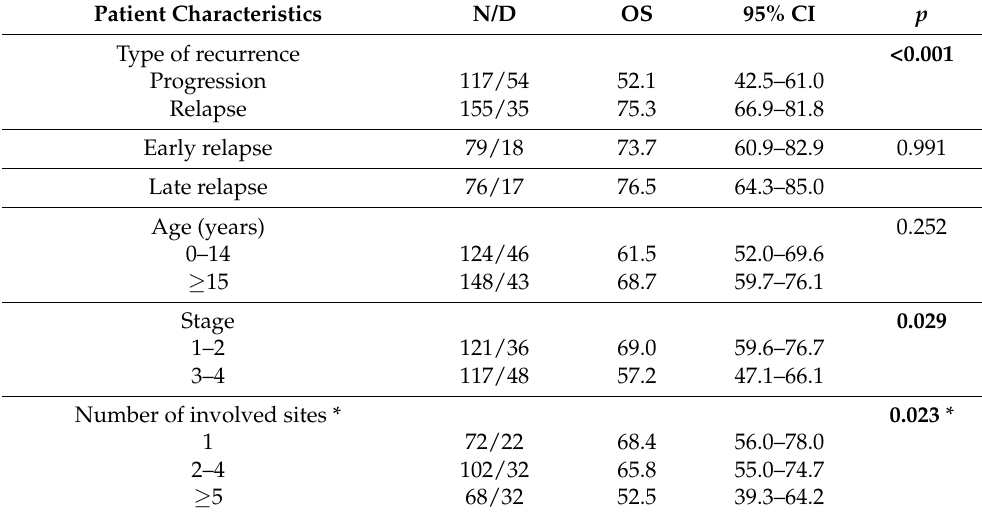
Table 6. Ten-year overall survival of 272 patients with classical Hodgkin’s lymphoma after recurrence by characteristics at